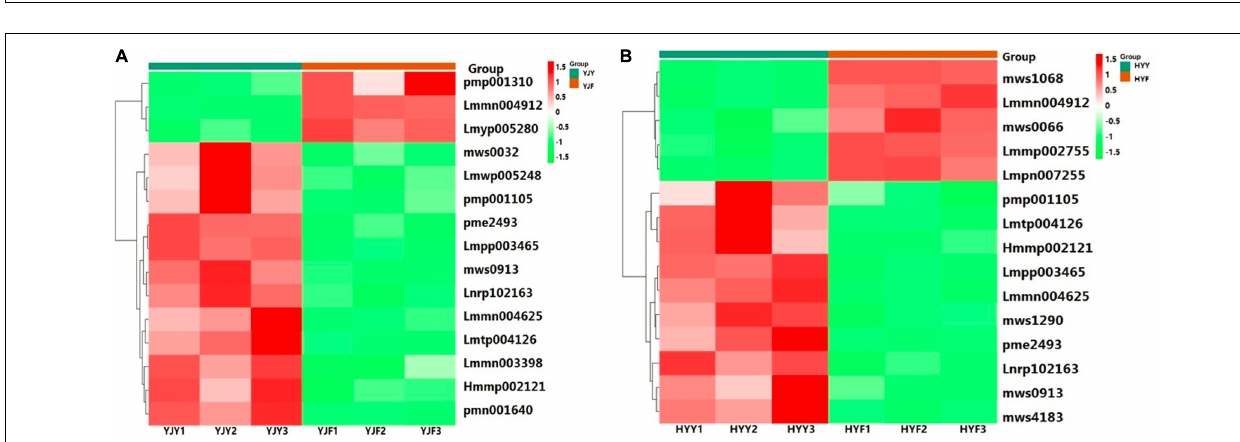
FIGURE 2 | The top 20 differential metabolites between “Yinghong 9” (YJ) and “Huangyu” (HY). (A) Top 20 FC differential metabolites between “Yinghong 9” (YJ) and “Huangyu” (HY), fold change (YJY/HYY). (B) Top 20 FC differential metabolites between fresh leaves (YJY) and fermented leaves (YJF)of “Yinghong 9,” fold change (YJY/YJF). (C) Top 20 FC change metabolites between Fresh leaves (HYY) and Fermented leaves (HYF)of “Huangyu,” fold change (HYY/HYF).